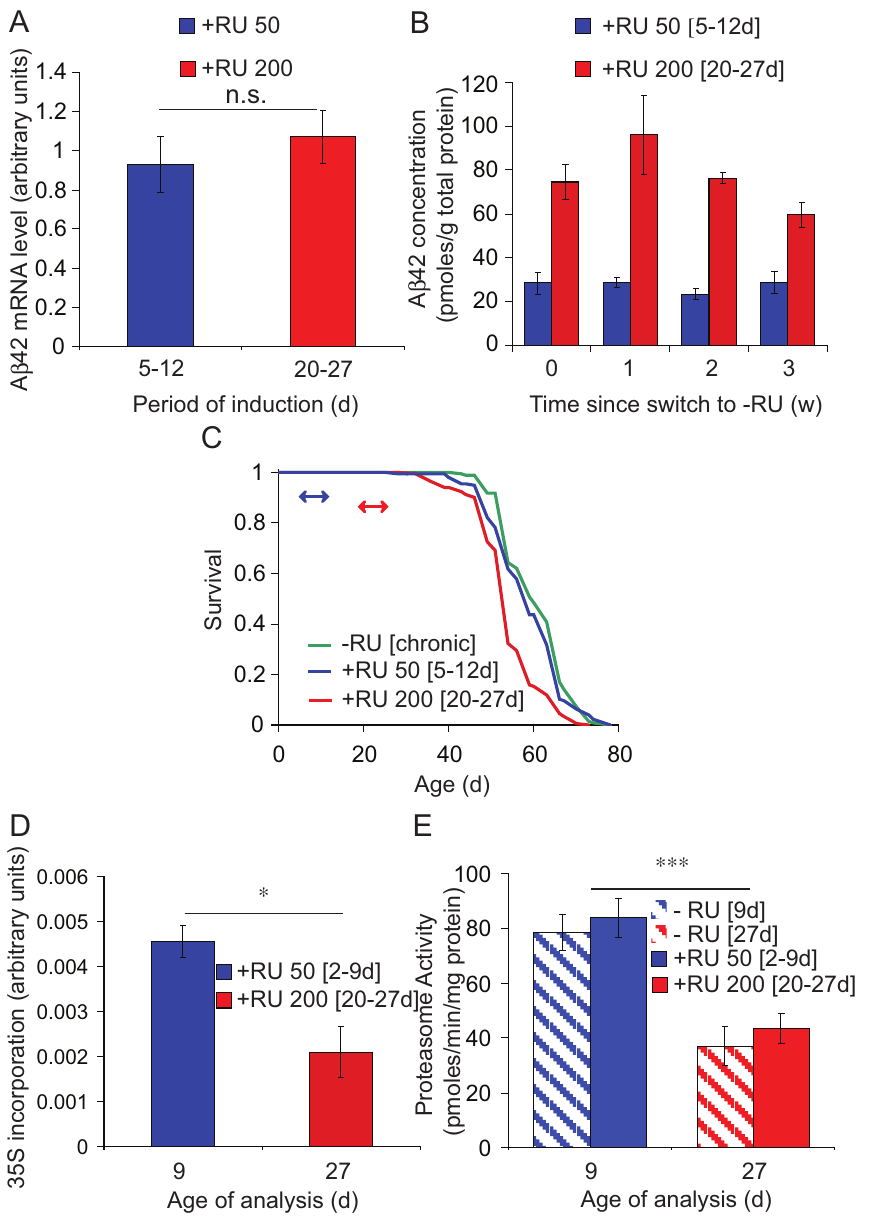
Figure 2. Ageing increases Arctic A b 42 peptide accumulation and toxicity when transcript levels are equalised at different ages. UAS-Arctic A b 42/ + ; elavGS/ + females were pulsed, for 1 week, either at 2 or 5 days old with 50 m M RU (RU 50 [2–9d] or [5–12d]) or 20 days old